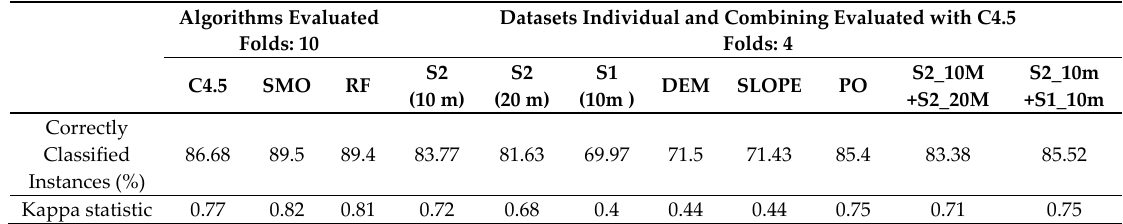
Table 1. True Positive percentage and kappa values of classification process with C4.5, RF and SMO